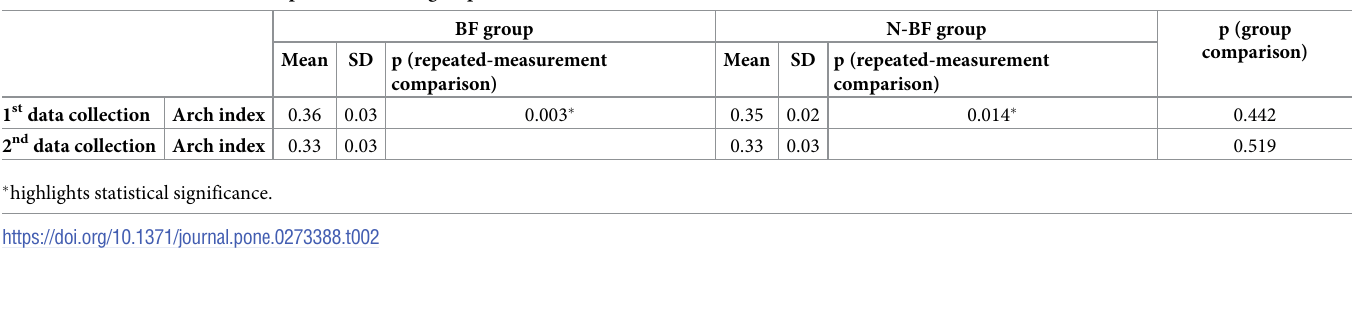
Table 2. Results of arch index comparison between groups and data collections.